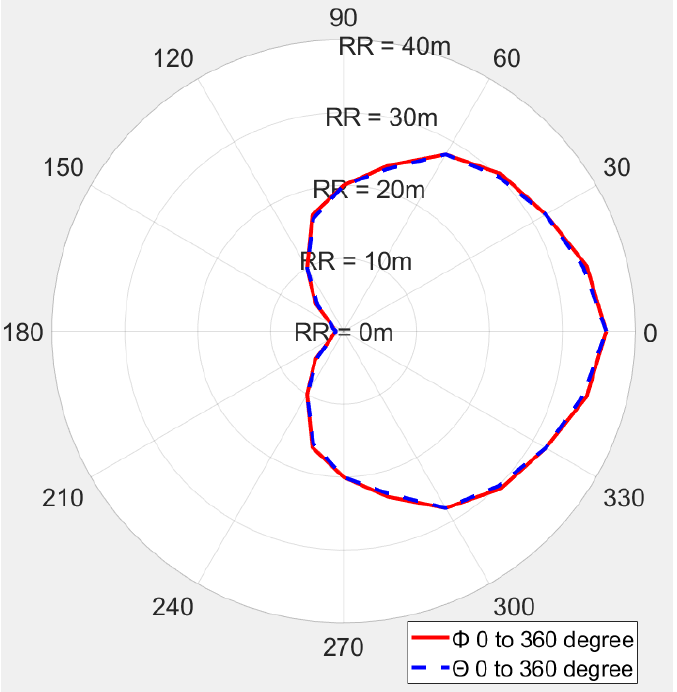
Figure 15. The reading range pattern of a fabricated long-range cavity tag antenna (CTA) ant_h9, CP reader antenna.